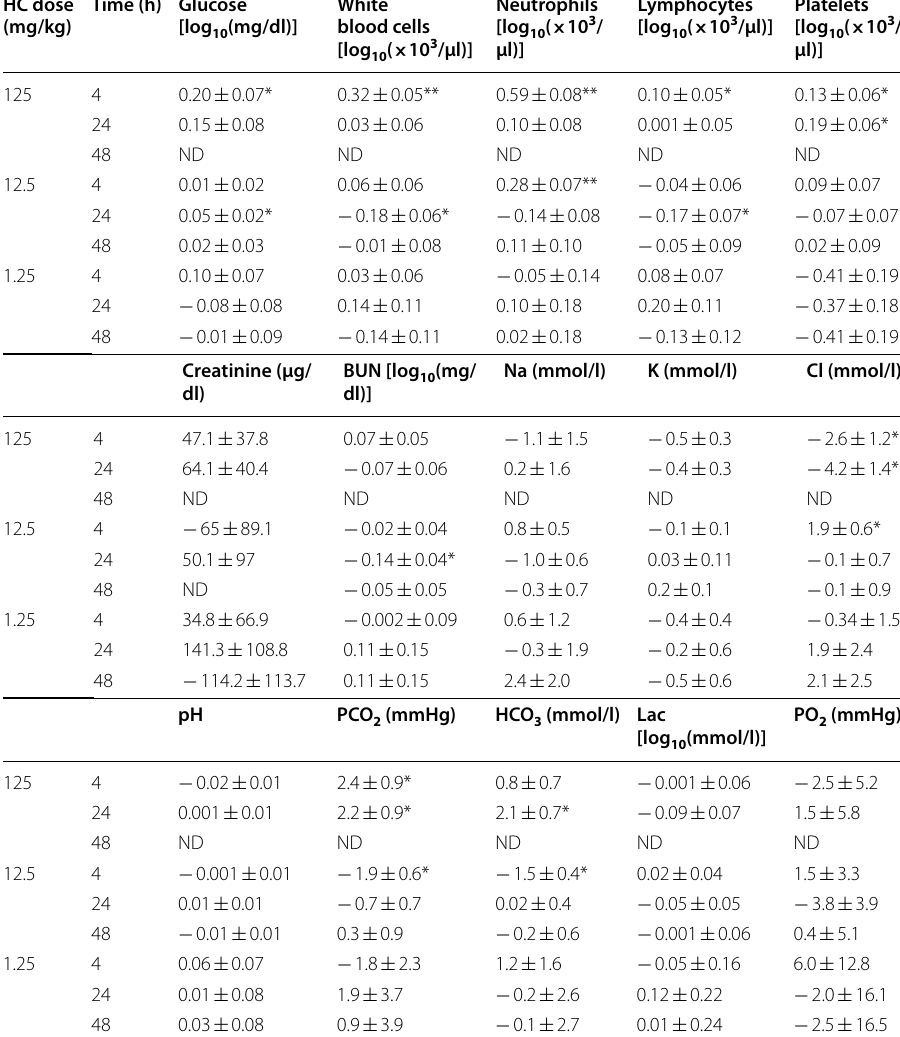
Table 1 Mean ( SEM) effect of high (125 mg/kg), medium (12.5 mg/kg), or low (1.25 mg/ ± kg) hydrocortisone compared to controls on glucose, leukocytes, platelets, creatinine, blood urea nitrogen, electrolytes, and arterial blood gas parameters at 4, 24 and 48 h after the start of peptidoglycan